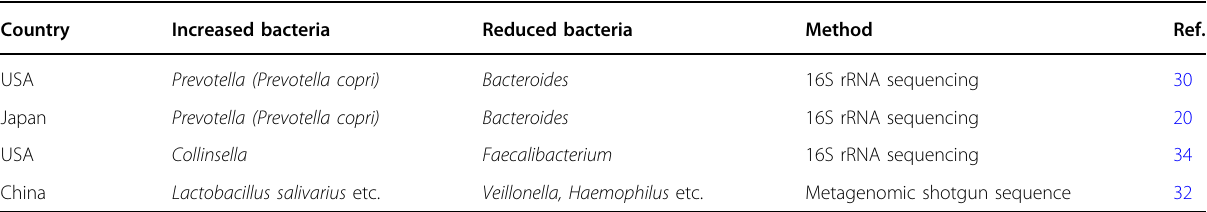
Table 2 Altered composition of the gut microbiota in human RA patients